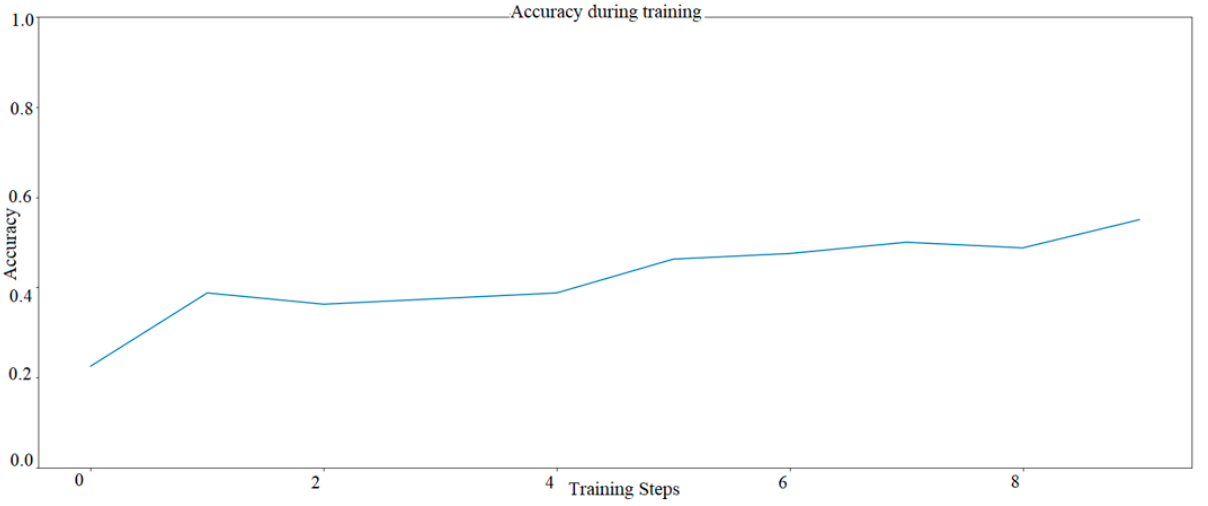
Figure 4. Learning progress of the AI model with Mobilenet layer—Model One AI. The graph was developed based on TensorFlow library.